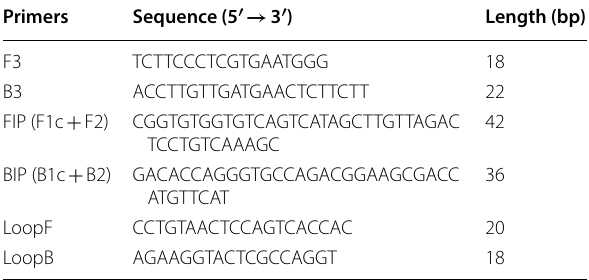
Table 4 The primer NS5-4 used for detection of Zika